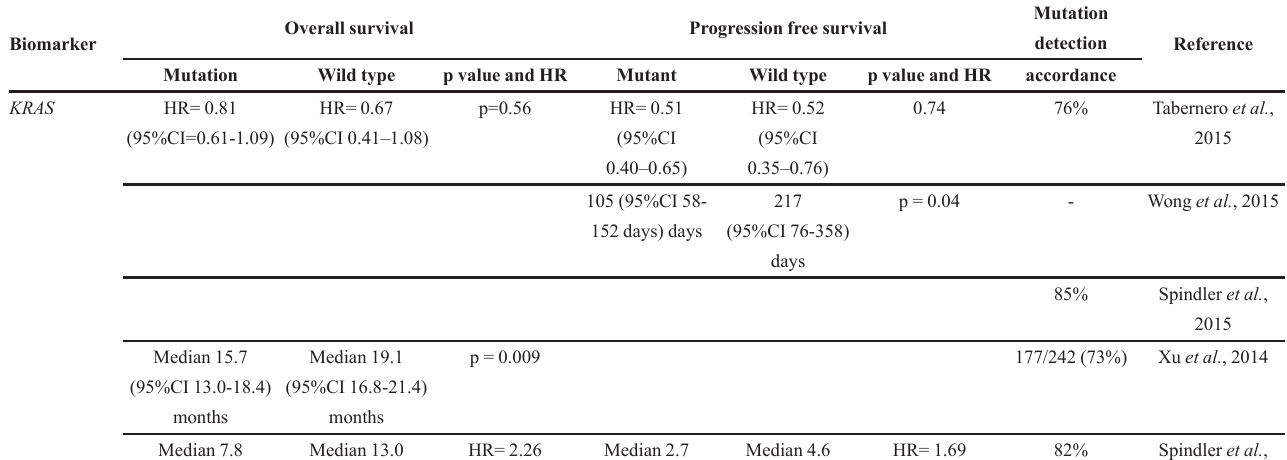
TABLE VII - Results for the detection of mutations in the ccfDNA for the CRC prognosis Overall survival Progression free Biomarker